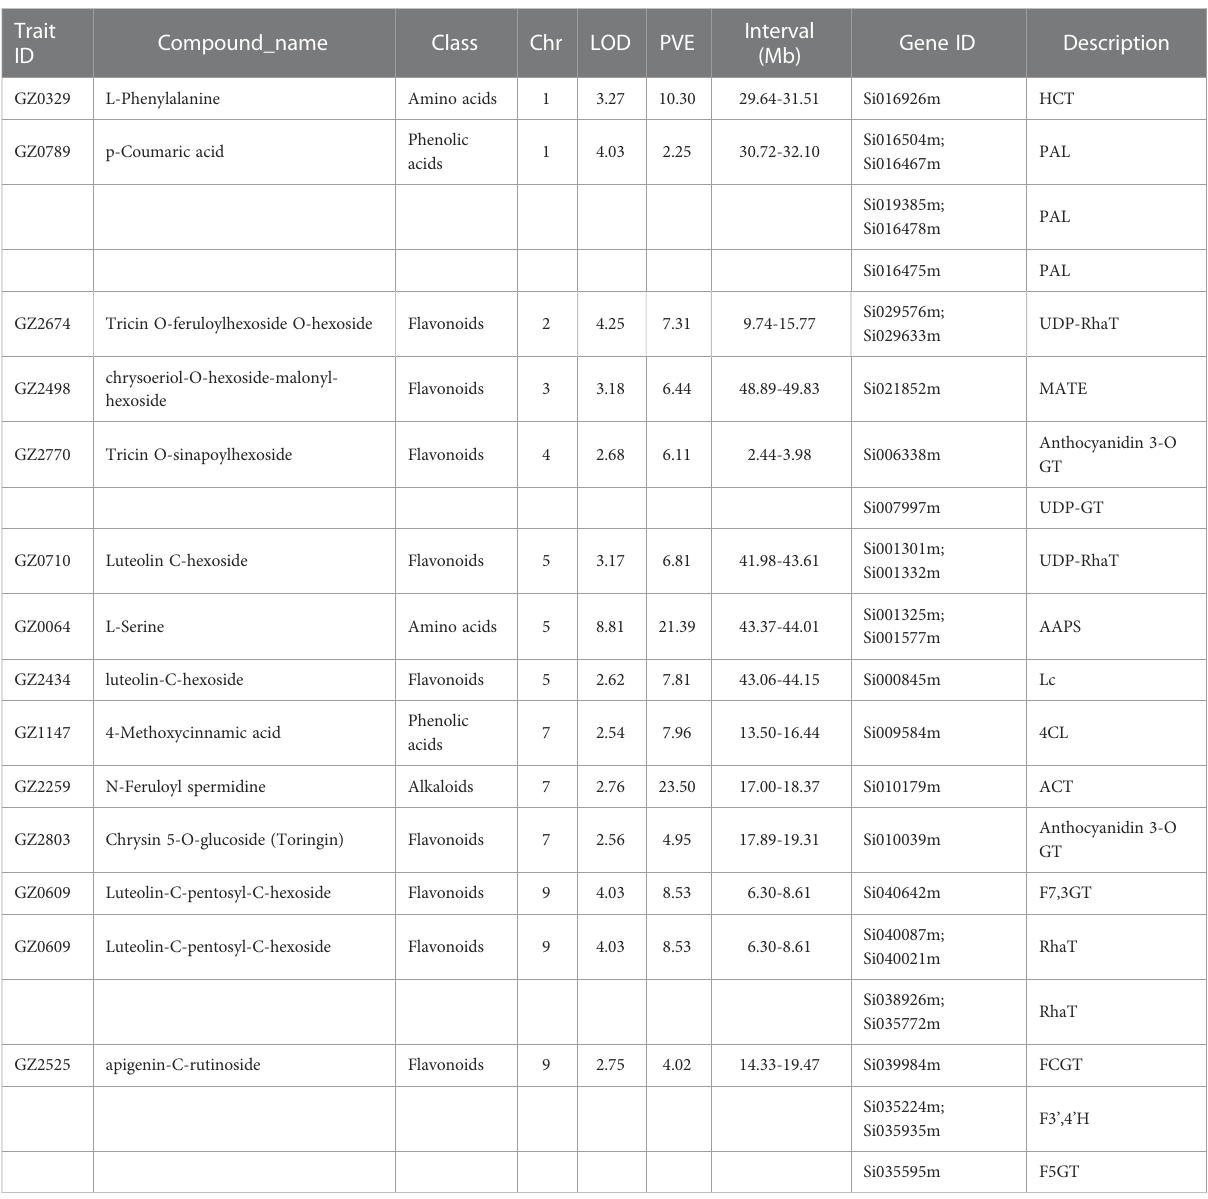
(Table 1). The most signi fi cant mQTL for GZ2498 (Chrysoeriol- O-hexoside-malonyl-hexoside) was a segment on chromosome 3 in 49.35 Mb (241.3-251.4 cM, LOD = 3.18, PVE = 6.44%). As a candidate gene at this locus, Si021852m had high homology to the reported Arabidopsis gene AtDTX41 (Blastp E-value=0.0, Identity: 60.9%), which encodes a MATE ef fl ux family protein involved in the pathway fl avonoid biosynthesis (Zhao and Dixon, 2009). QTL of GZ2770 (Tricin O-sinapoylhexoside) was mapped to the 2.44-3.98 Mb on Chromosome 9 (28.3-45.8 cM, LOD=2.68 and PVE=6.44), Si006338m , Si008637m and Si006185m in the interval were homologous with a TABLE 1 Candidate genes based on mQTL results.